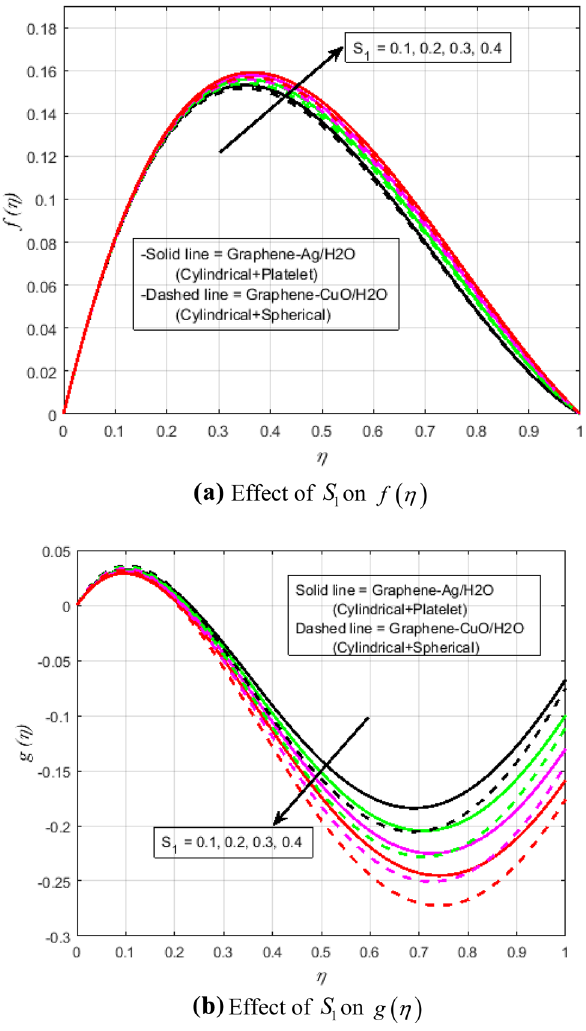
Figure 5. (a) Effect of S 1 on f (η) . (b) Effect of S 1 on g (η) .